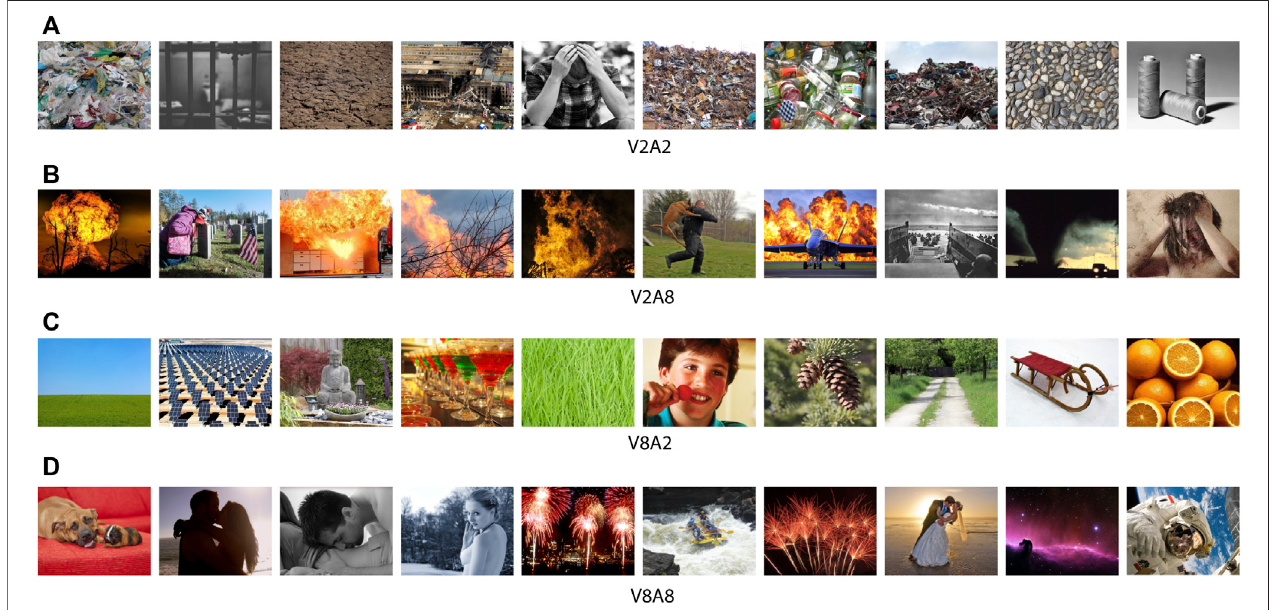
FIGURE 3 | Image sequences, from top to bottom: (A) V2A2, (B) V2A8, (C) V8A2, and (D)